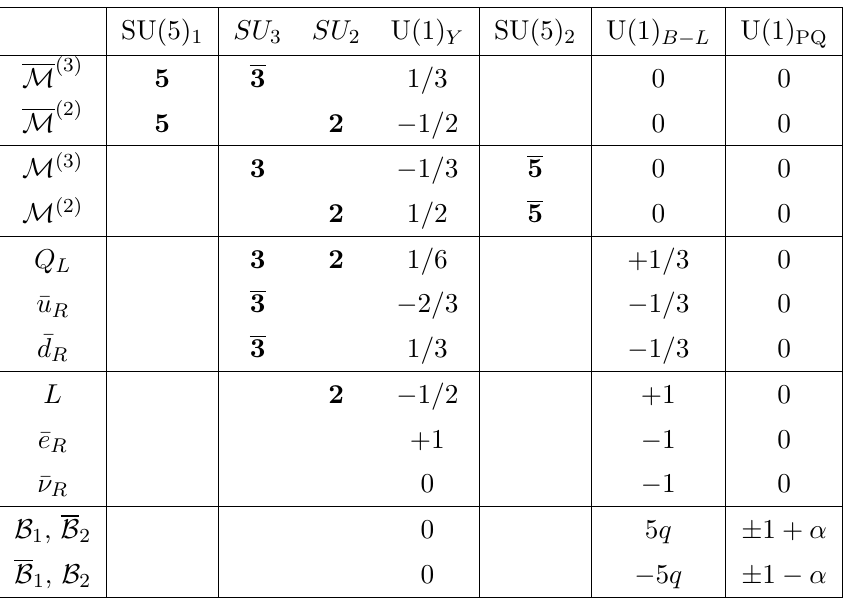
Table 2 . Transformation representations of the super(cid:12)elds for the U(1) X = U(1) B (cid:0) L model. q can be identi(cid:12)ed by considering all of the low-dimensional SU(5) nonzero B L (cid:0)